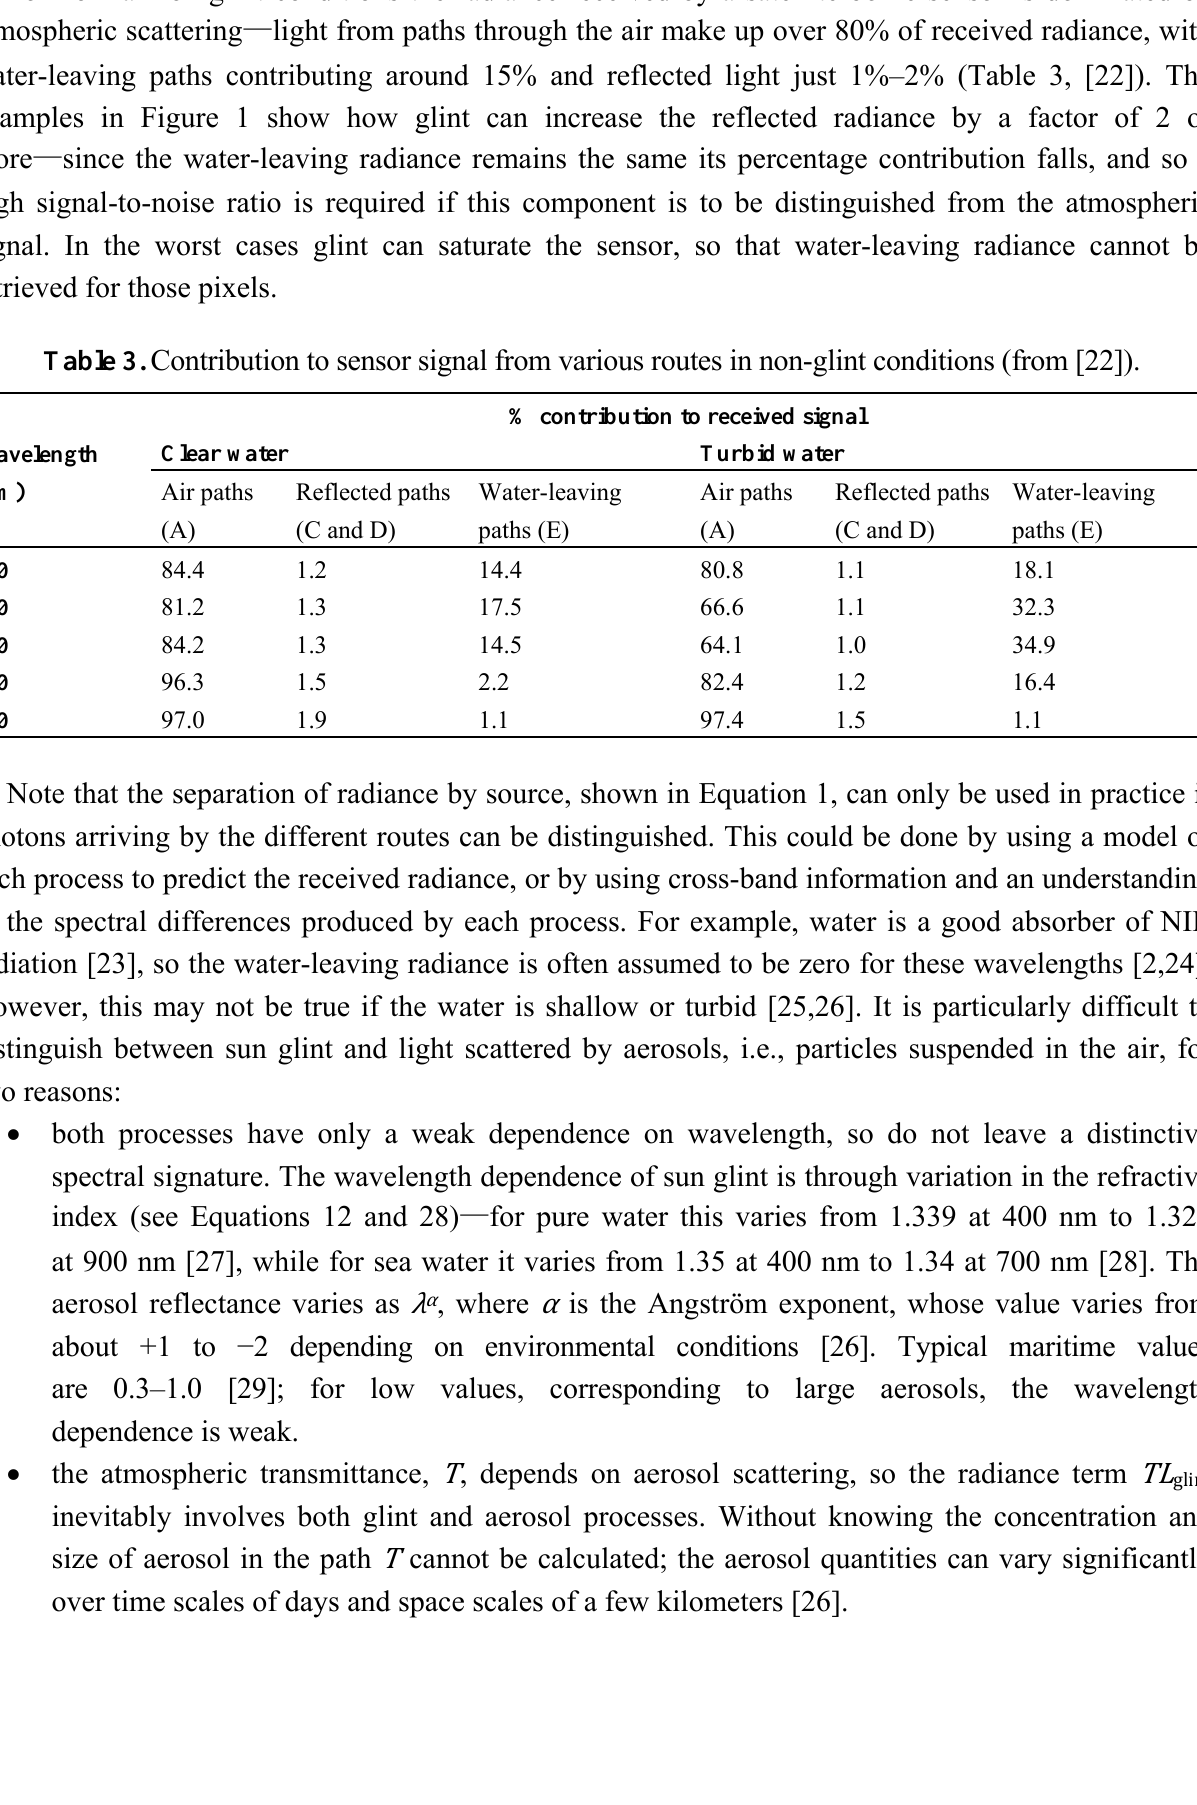
Table 3. Contribution to sensor signal from various routes in non-glint conditions (from [22]). Wavelength (nm)